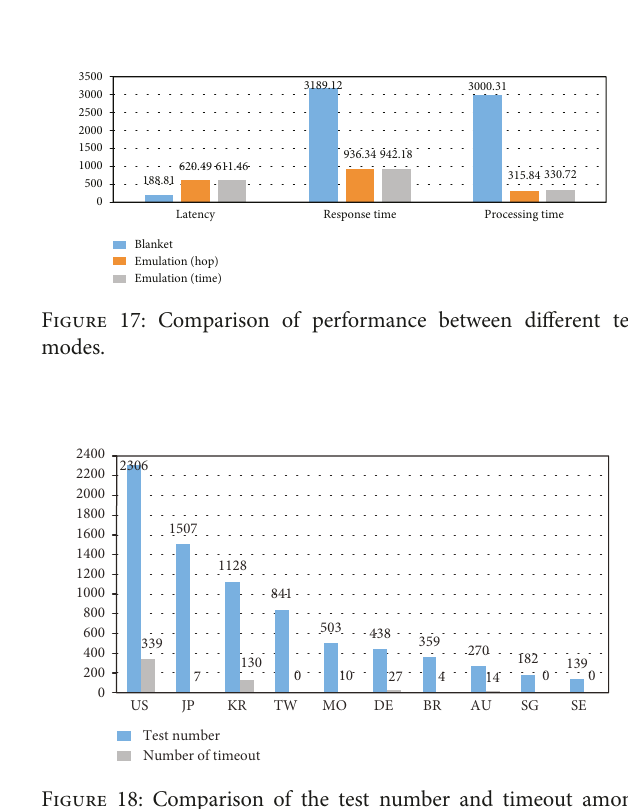
Figure 15: Test result of the emulation mode with time (request distribution).